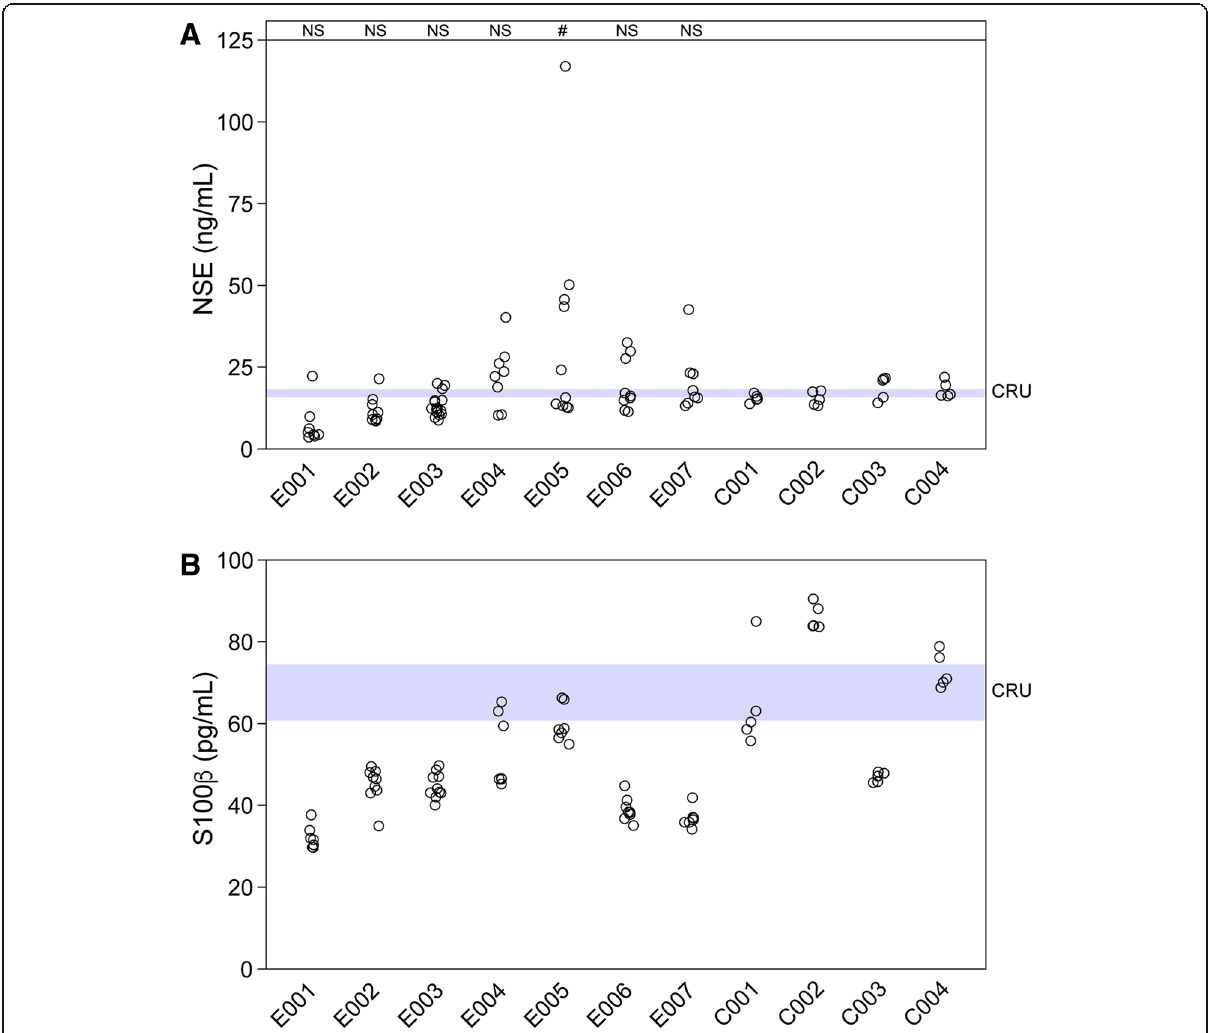
Fig. 1 Serum levels of NSE and S100 β in epilepsy patients and healthy controls are not different when analyzed in aggregate. a Multiple serum samples were collected from 7 patients in the epilepsy monitoring unit (EMU) at different times (6 AM, 9 AM, noon, 3 PM, and 6 PM) during several days of monitoring; each sample is represented by one dot. NSE was measured in serum collected from 4 healthy control subjects in the clinical research unit (CRU) at 6 AM, 9 AM, noon, 3 PM, and 6 PM during 1 day to establish a reference range for samples collected under conditions identical to the EMU patients (blue bar shows mean ± 95% CI; each sample is represented by one dot). Data are not normally distributed (W = 0.6415, P < 0.001 by Shapiro-Wilk test). One-way ANOVA with Dunnett ’ s pairwise comparison to group CRU controls revealed that NSE levels were only signficantly elevated in 1 of the 7 EMU patients (# = P < 0.01; NS = not signficant). b The same EMU and CRU serum samples used for NSE were assessed for S100 β (blue bar shows mean ± 95% CI for CRU controls). S100 β levels were not elevated in any of the